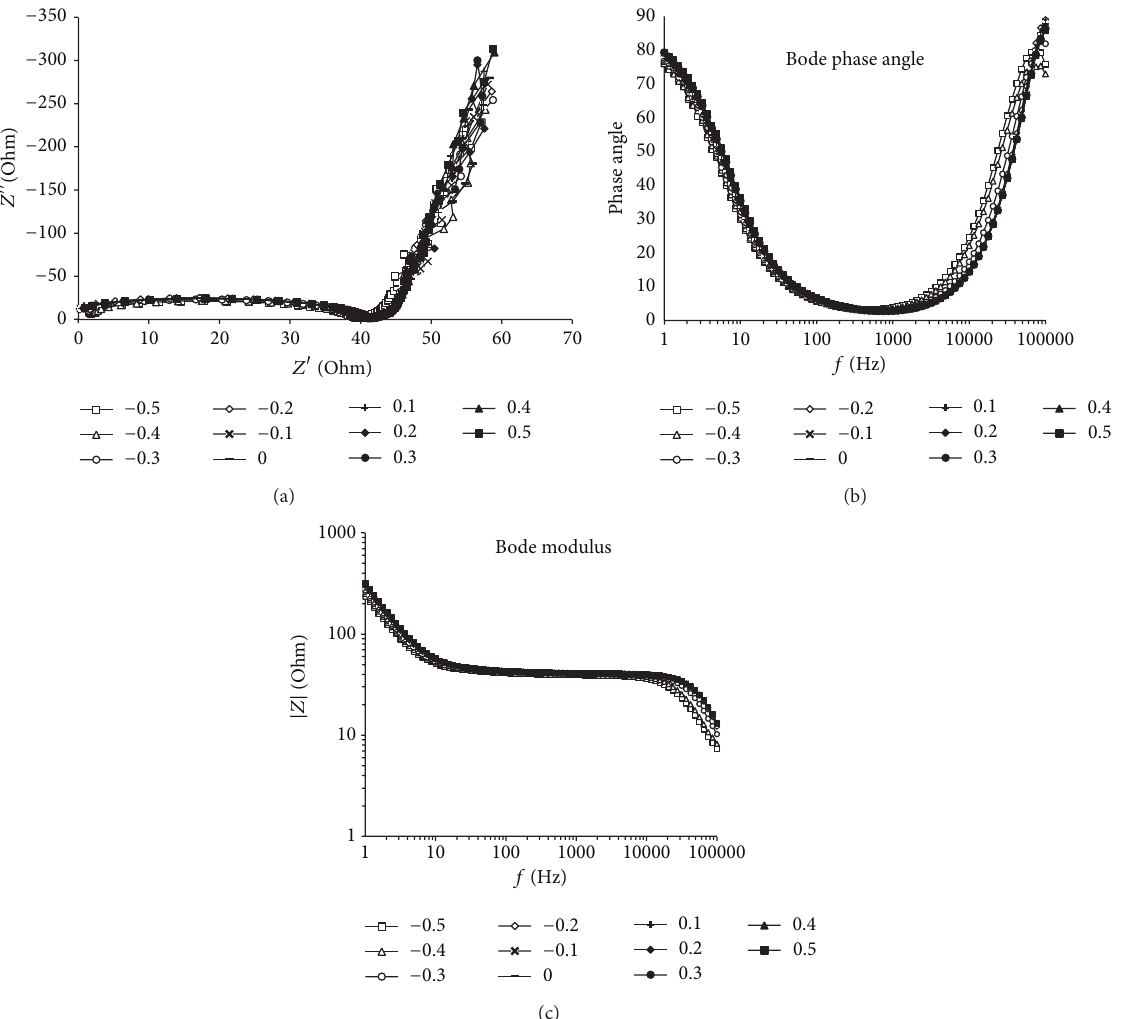
Figure 5: EIS spectra of NTD sample, recorded at different bias potentials in